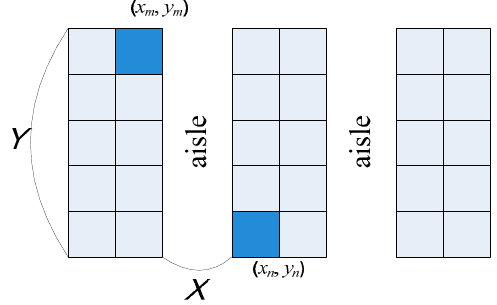
Figure 3. A typical store layout showing the cell relationship.